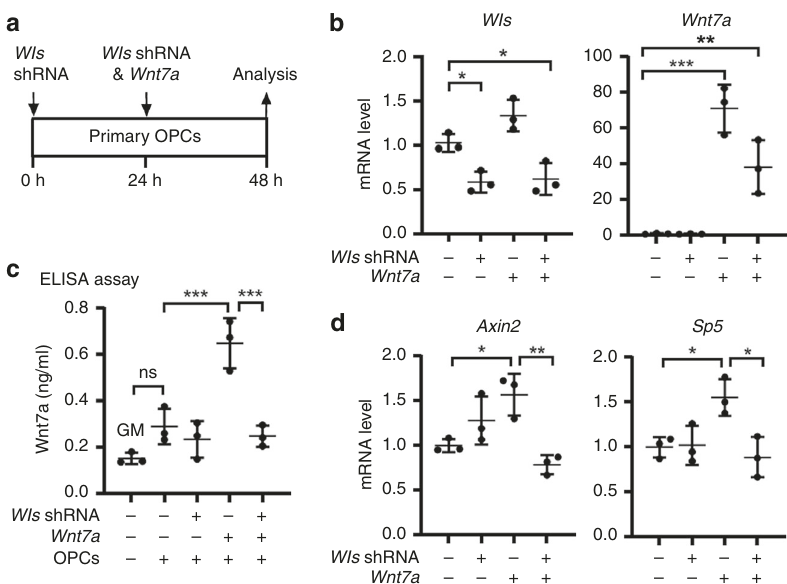
Fig. 3 WLS is required for Wnt secretion from OPCs. a brain primary OPCs growing in the growth medium (GM) were transfected with Wls -shRNA and Wnt7a plasmids, and OPC mRNA and culture medium were collected for analysis 48 hours (h) after the fi rst Wls -shRNA transfection. b RT-qPCR assay of Wls and Wnt7a mRNA in transfected primary OPCs. One-way ANOVA followed by Tukey ’ s multiple comparisons, * P < 0.05, ** P < 0.01, *** P < 0.001. F (3,8) = 17.41, P = 0.007 Wls , F = 33.82, P < 0.0001 Wnt7a . n = 3 each group. c ELISA measurement of Wnt7a protein concentration in the GM in the absence and presence of OPCs in the dish with Wls-shRNA and Wnt7a transfection. One-way ANOVA followed by Tukey ’ s multiple comparisons, *** P < 0.001, ns not signi fi cant. F (4,10) = 21.02, P < 0.0001. Note that Wnt7a concentration in the GM in the presence of primary OPCs is not statistically different from that in the GM in the absence of primary OPCs. n = 3 each group. d RT-qPCR assay of Wnt target genes Axin2 and Sp5 in OPCs. One-way ANOVA followed by Tukey ’ s multiple comparisons, * P < 0.05, ** P < 0.01. F (3,8) = 9.632, P = 0.0049 Axin2 , F (3,8) = 6.965, P = 0.0128 Sp5 . n = 3 each group. Data are shown as mean ± s.d. Source data of b – d are provided as a Source Data fi